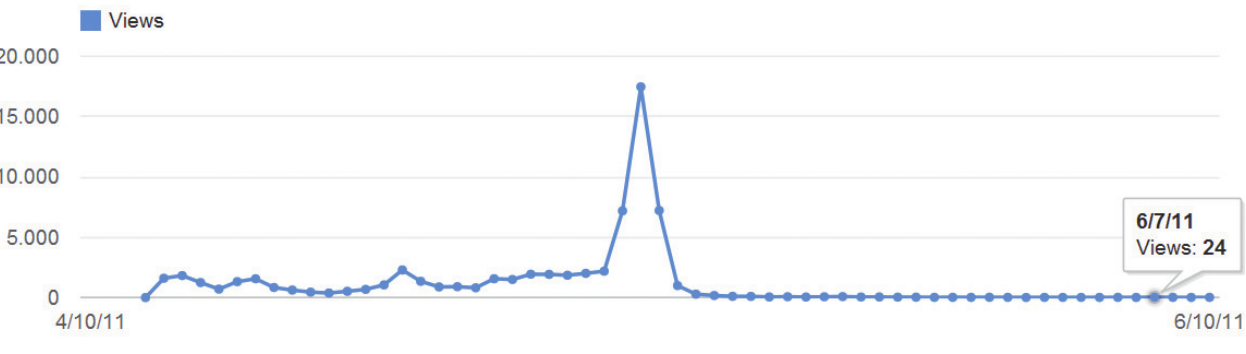
Figure 3. Number of daily views for the video Terremoto a Roma l’11 maggio 2011? (Earthquake in Rome on May 11, 2011?), which scored a total of more than 67,000 views. The peak was reached the day before the prediction (May 10), with about 18,000 405